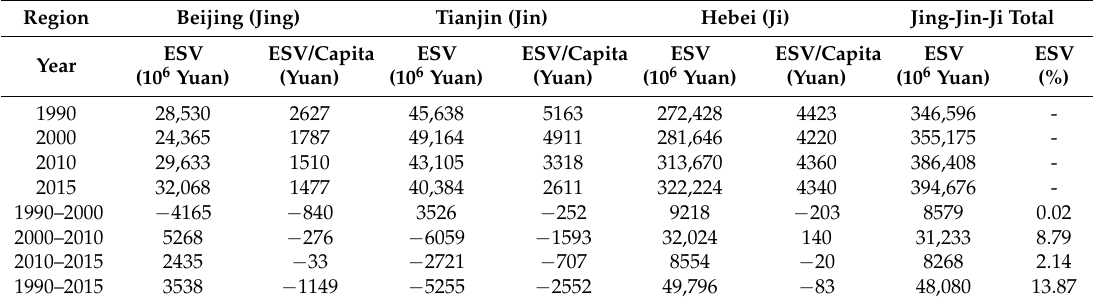
Table 2. Changes in ecosystem service values (ESVs) from 1990 to 2015 in the Jing-Jin-Ji region. Region Beijing (Jing) Tianjin (Jin)